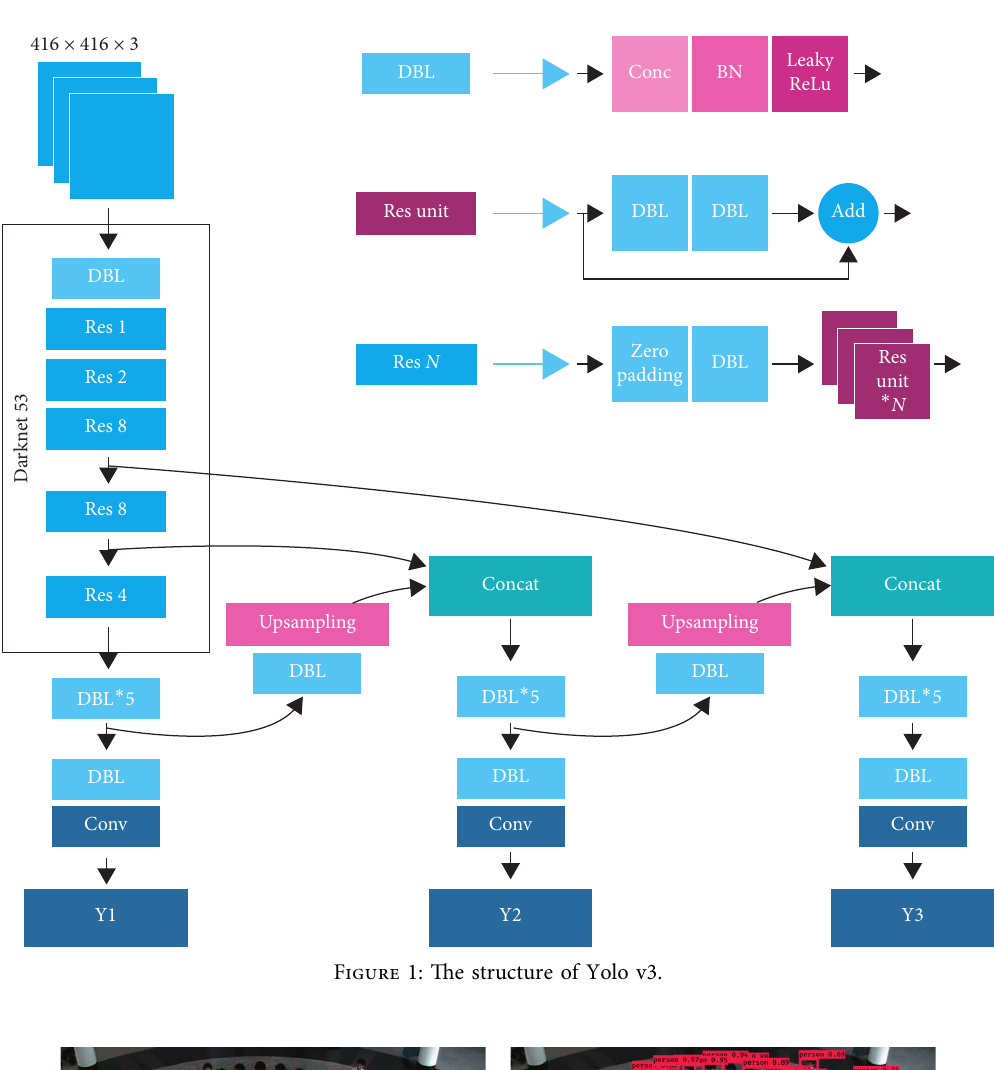
Figure 1: The structure of Yolo v3.